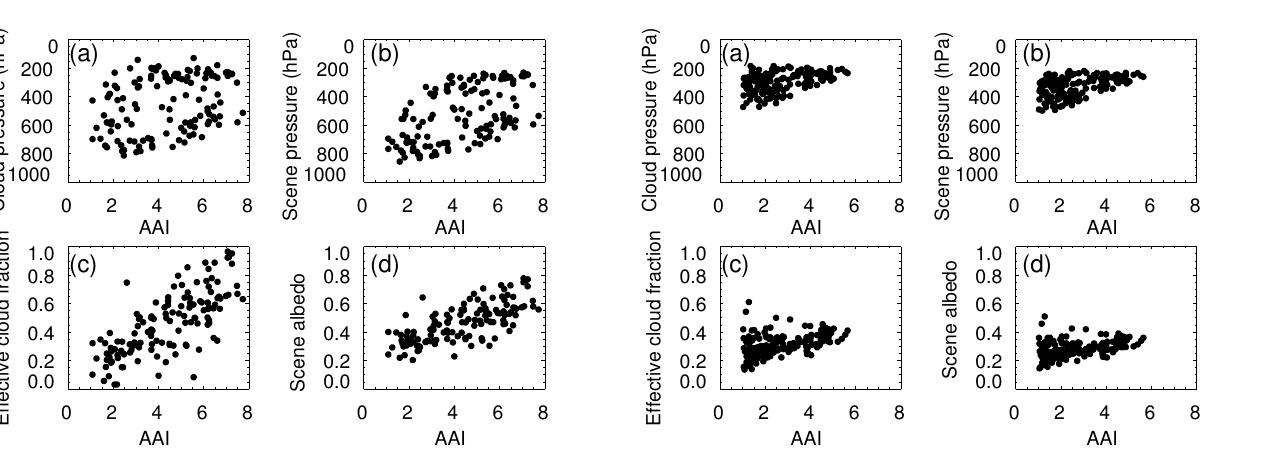
2011 at 12:00 UTC appeared to have similar patterns as those observed by GOME-2 on 6 June 2011 at 13:00 UTC (not shown). According to the HYSPLIT simulation, the plume in the right box of Fig. 11 was located between FL350 (flight level 35000 feet) and FL200, which has a good agreement sure between 200–400